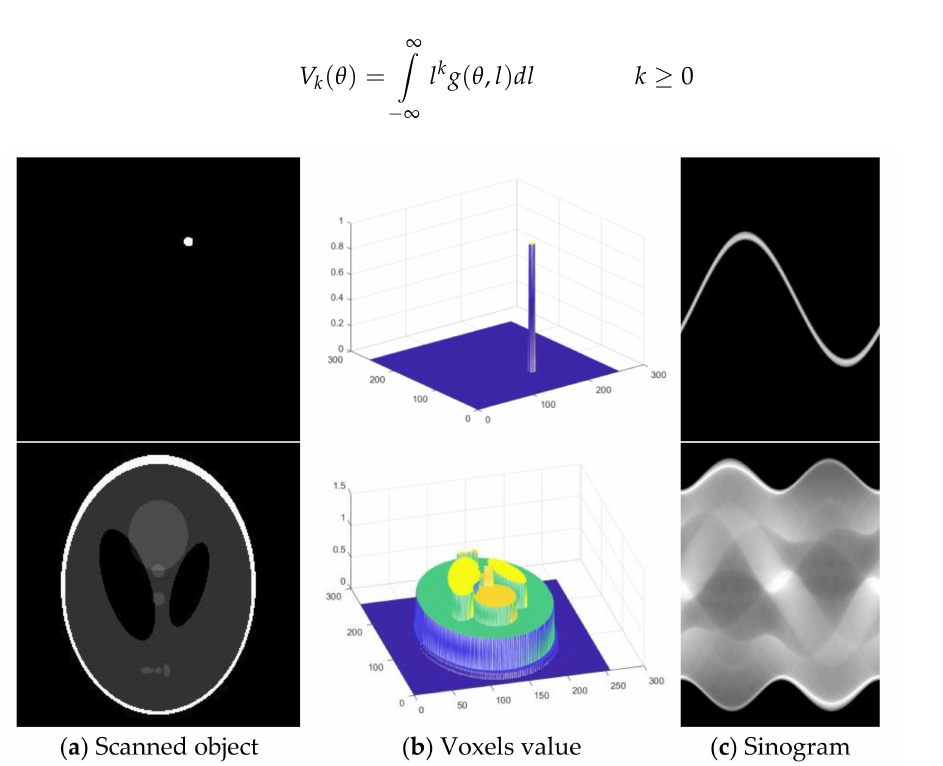
Figure 3. Schematic diagram of data characteristics of a projection sinogram.